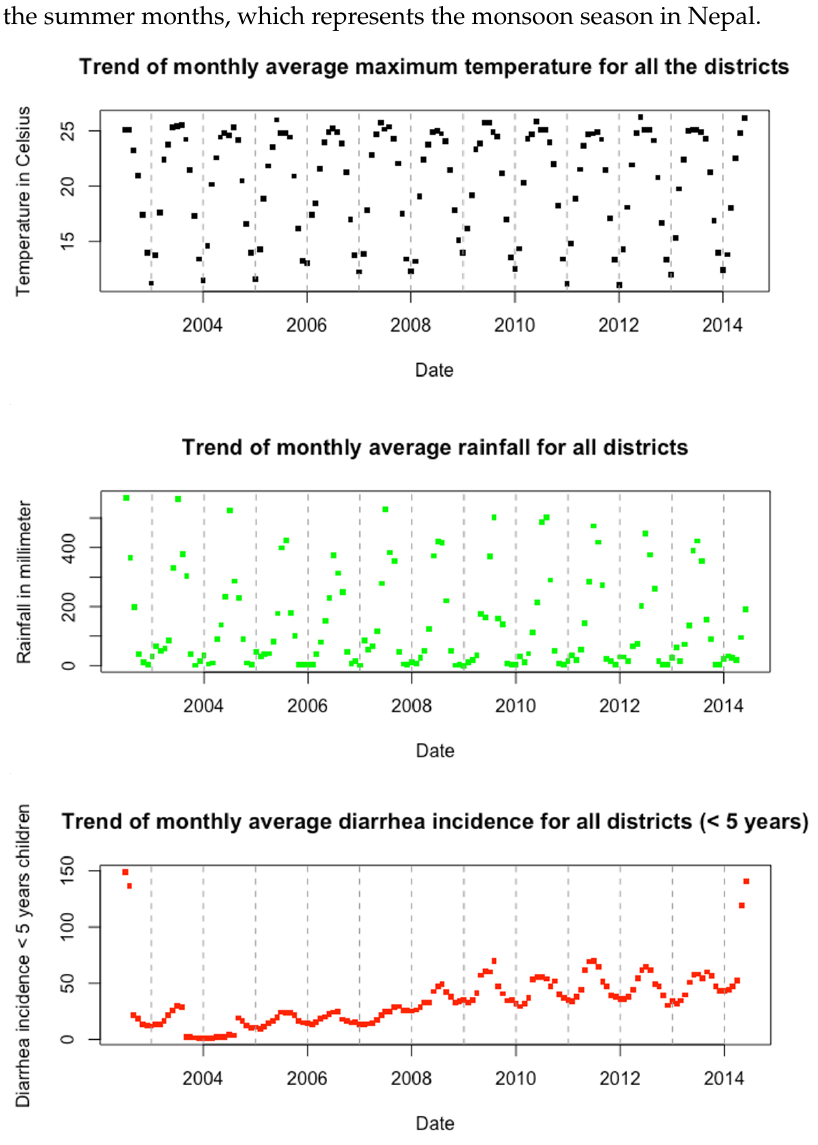
Figure 2. National level monthly time-series plot of climatic variables and diarrheal incidence (July 2002–June 2014) on average across all districts in 2002 – June 2014) on average across all districts in Nepal.